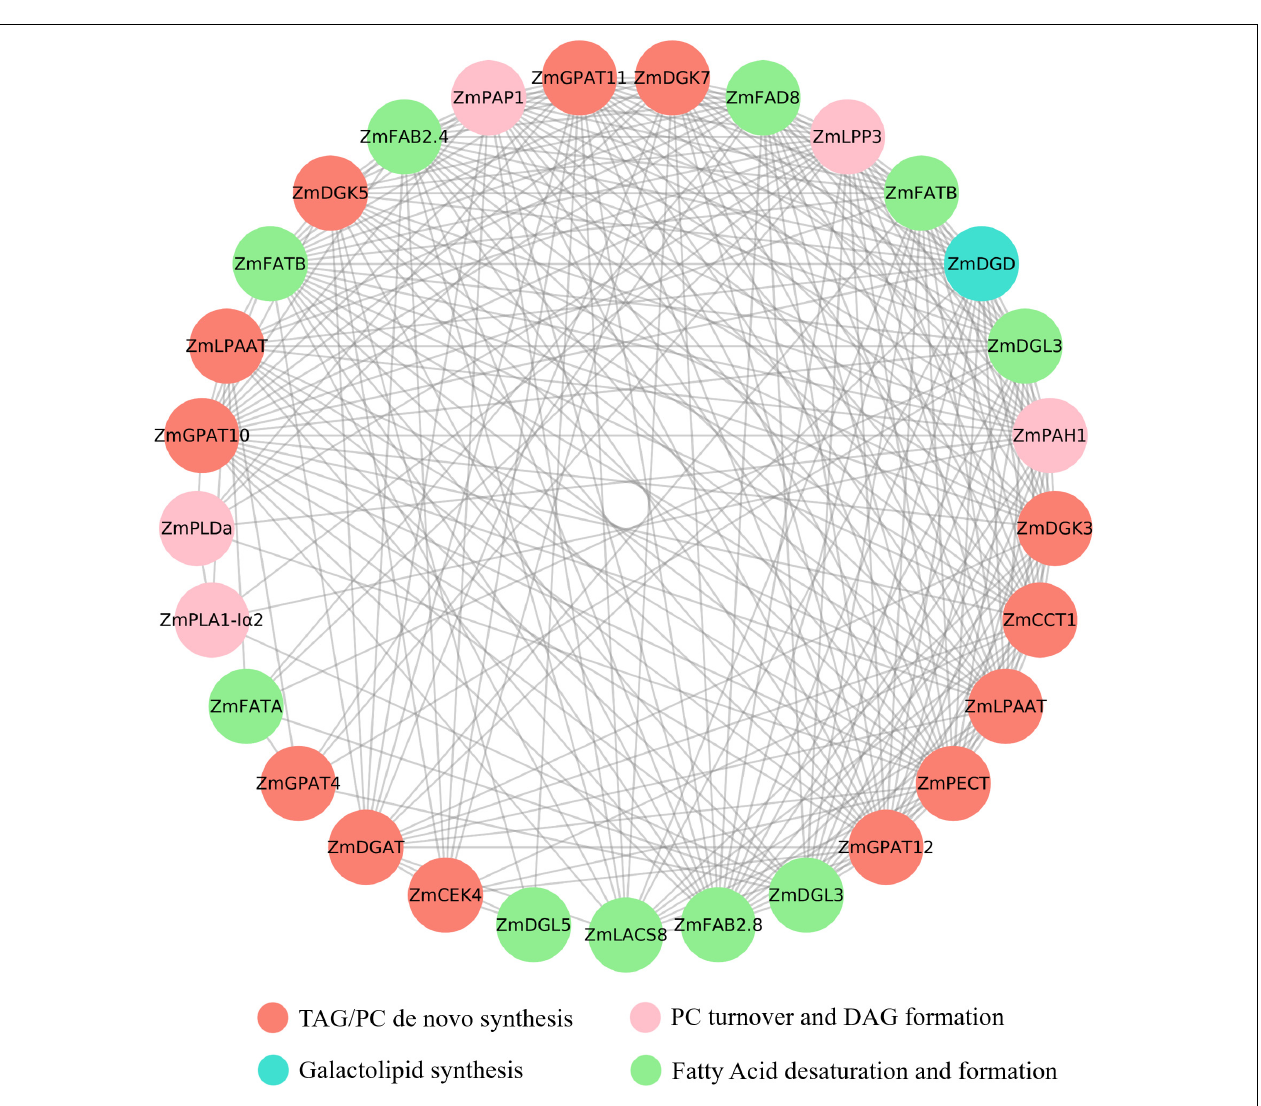
Frontiers in Plant Science |